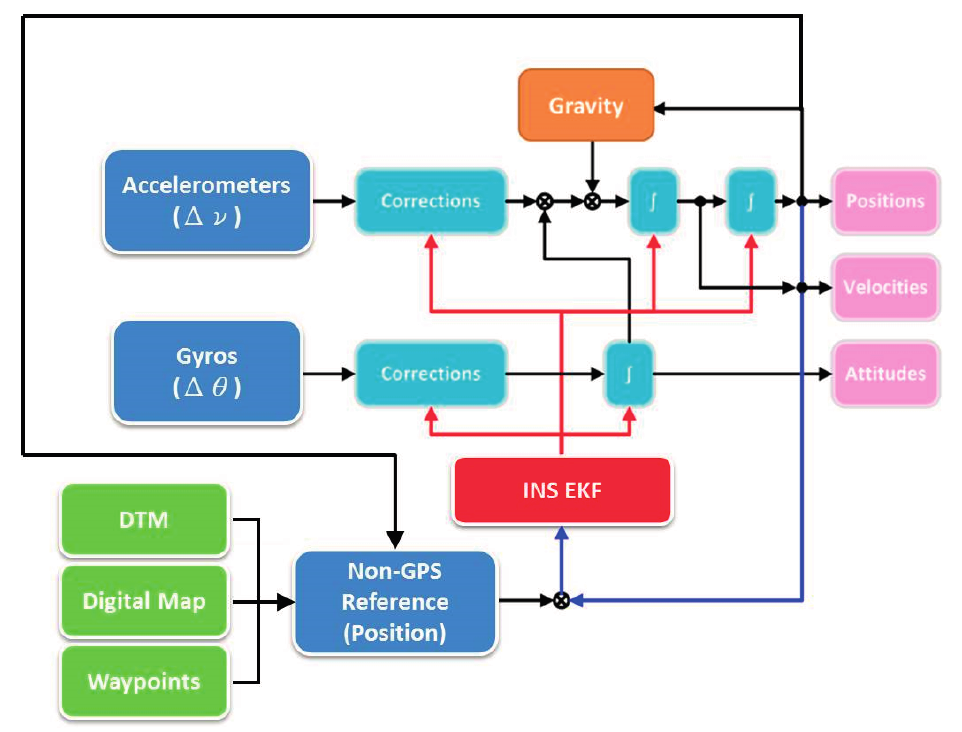
Figure 4. The architecture of proposed algorithm (closed